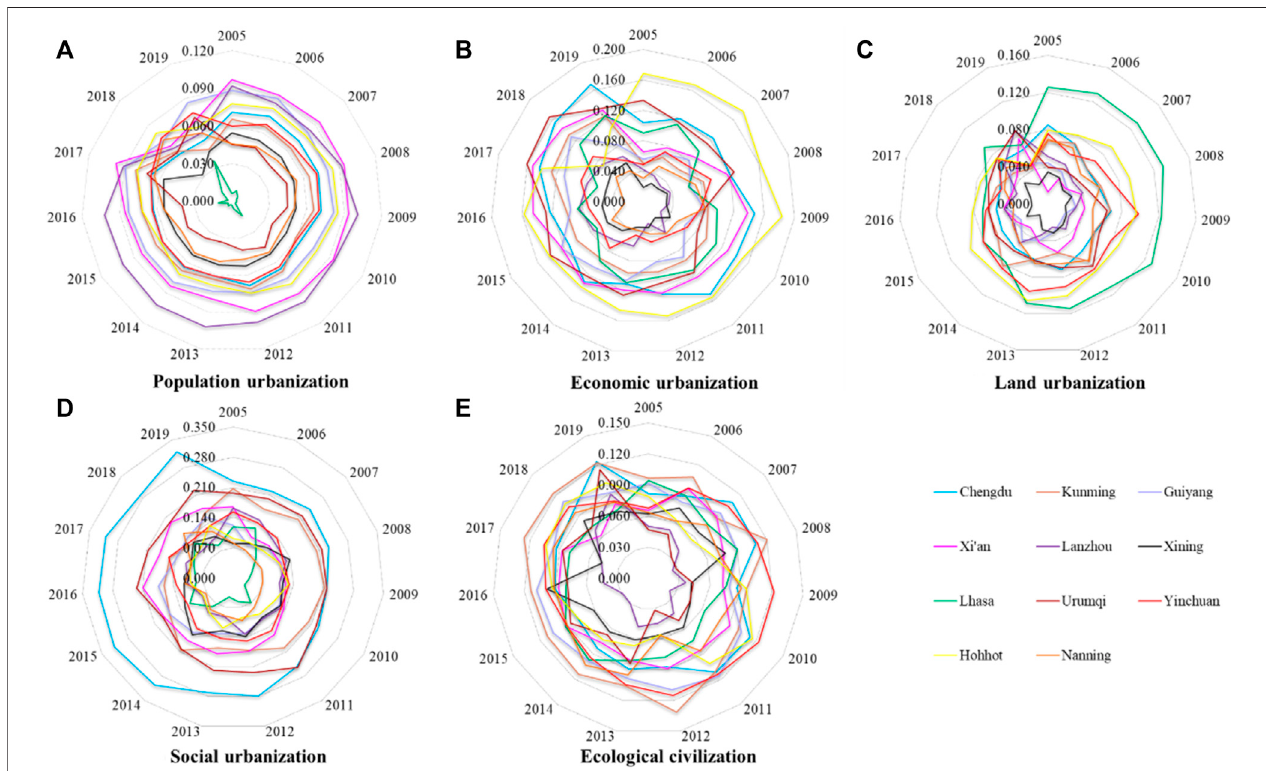
FIGURE 7 | The single urbanization scores of each city from 2005 to 2019. (A) Population urbanization. (B) Economic urbanization. (C) Land urbanization. (D) Social urbanization. (E) Ecological civilization.